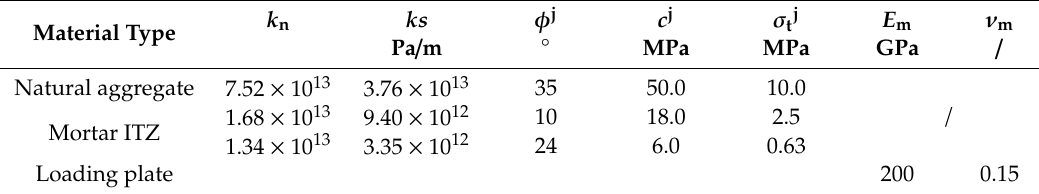
Table 1. Micro-mechanical parameters used in numerical